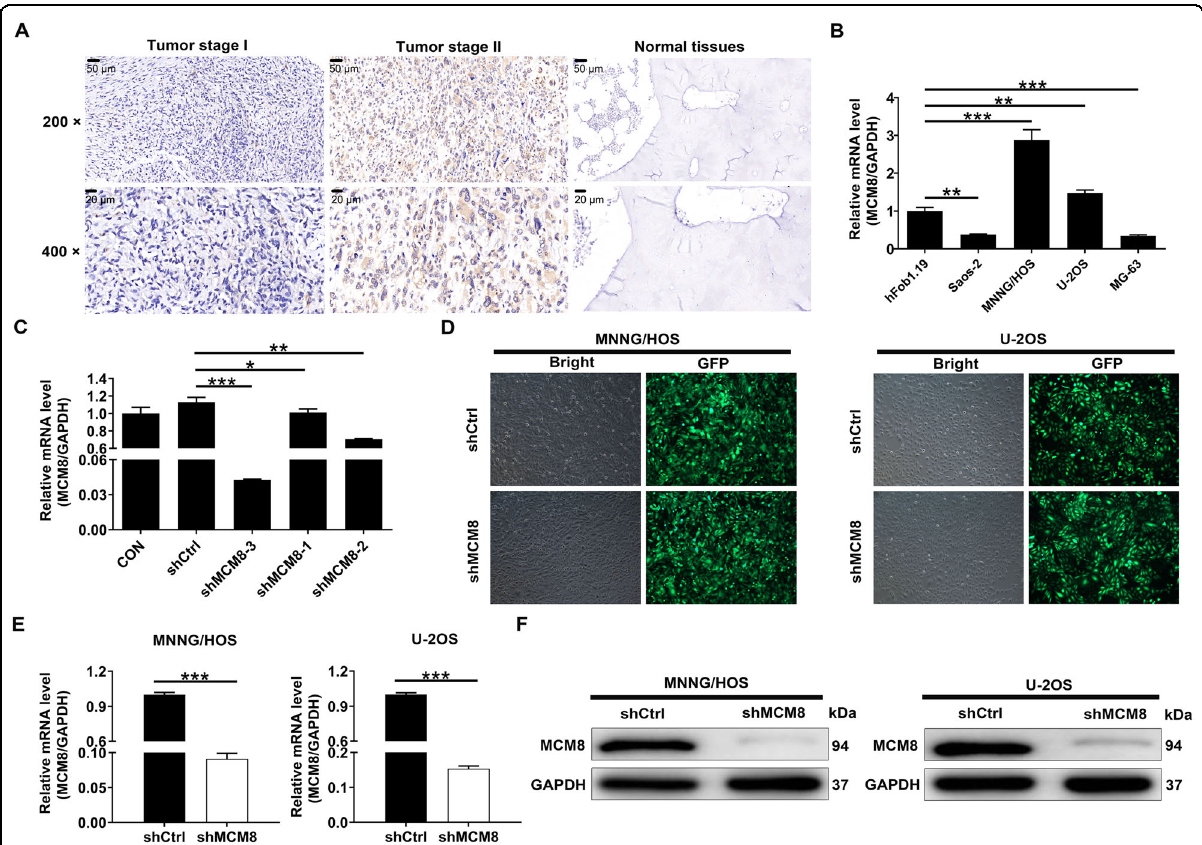
Fig. 1 MCM8 was upregulated in osteosarcoma and MCM8 knockdown cell model was constructed. A The expression levels of MCM8 in osteosarcoma tumor tissues and paracarcinoma tissues were determined by immunohistochemical staining. B The expression levels of MCM8 in hFOB1.19 cell line and osteosarcoma cell lines were determined by qRT-PCR. C The knockdown ef fi ciencies of MCM8 in MNNG/HOS cells were evaluated by qRT-PCR. D The transfection ef fi ciencies of shMCM8 in MNNG/HOS and U-2OS cells were evaluated through observing the fl uorescence of GFP. Magni fi cation times: ×200. E The MCM8 expression in osteosarcoma cell lines after transfection was analyzed by qRT-PCR. F The expression of MCM8 protein in osteosarcoma cell lines after transfection was detected by western blot. Results were presented as mean ± SD. * P < 0.05, ** P < 0.01, *** P <